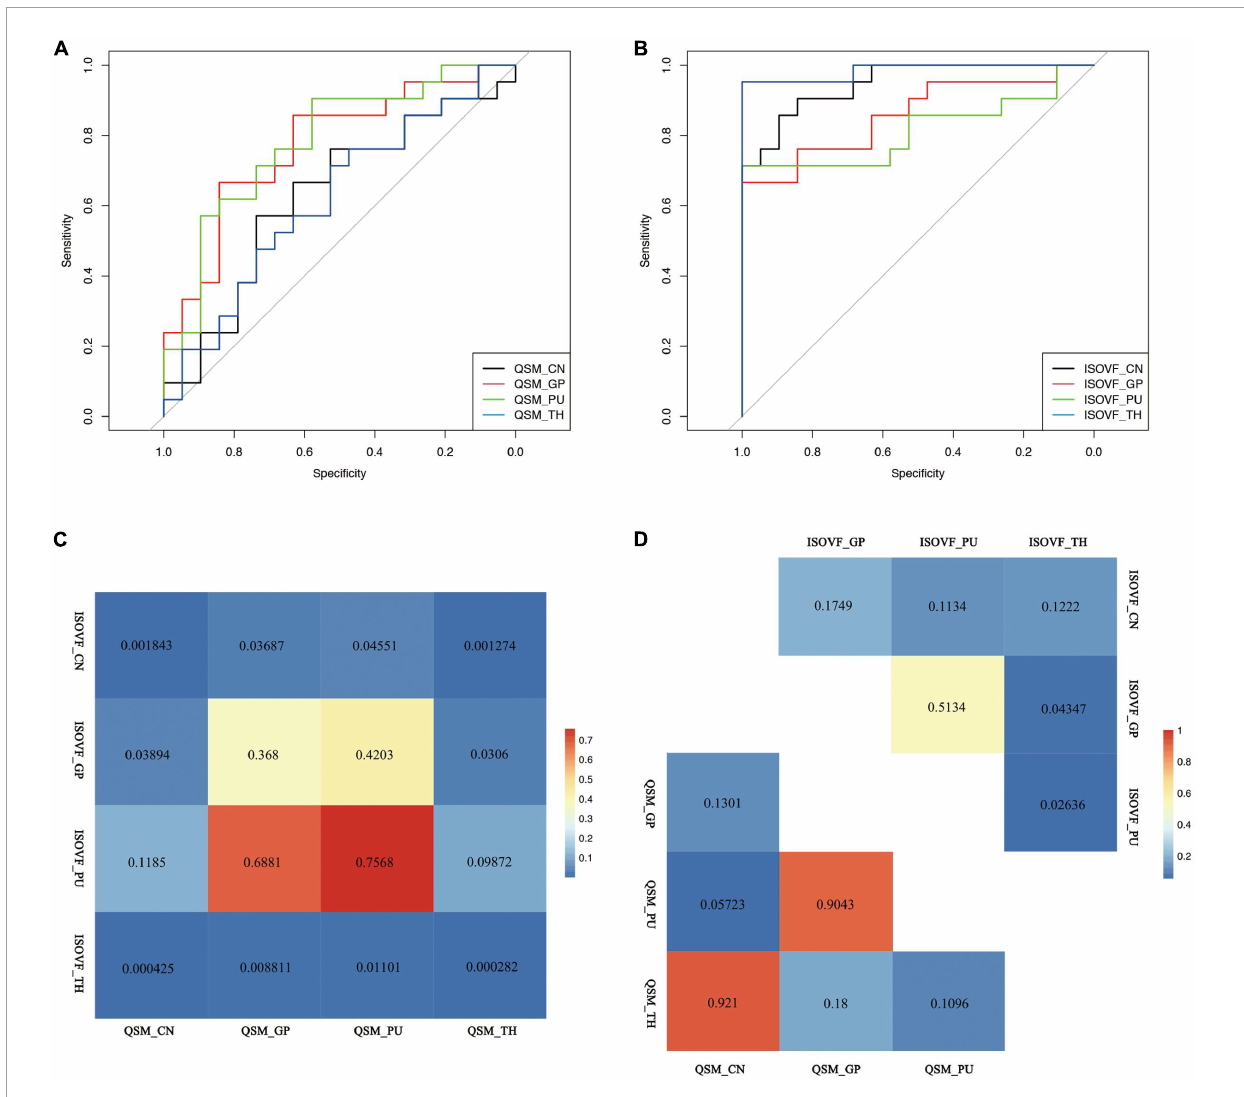
FIGURE3 Receiver operating curve (ROC) curve of (A) QSM and (B) ISOVF value of the CN, GP, PU, and TH and inter-group (C) and intra-group (D) comparison of the diagnostic value of ISOVF and QSM values. QSM, quantitative susceptibility mapping; ISOVF, isotropic volume fraction; CN, caudate nucleus; GP, globus pallidus; PU, putamen; TH,